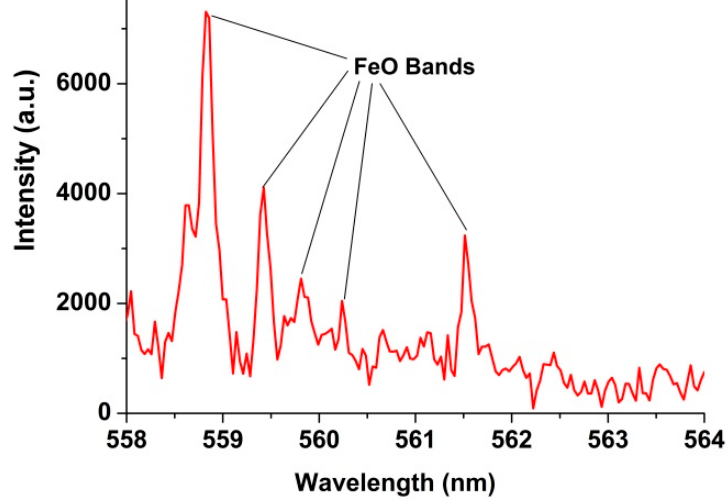
Figure 2. FeO molecular bands recorded with LIBS of the Dergaon meteorite.